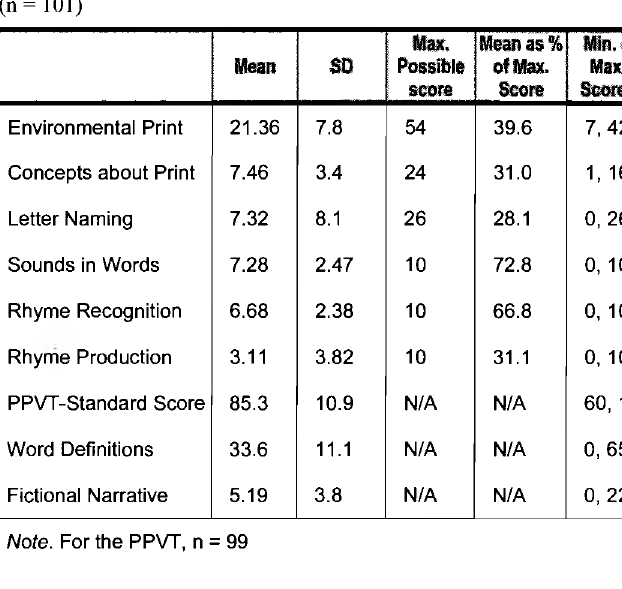
Table 2: Descriptive Statistics for the Literacy Outcome